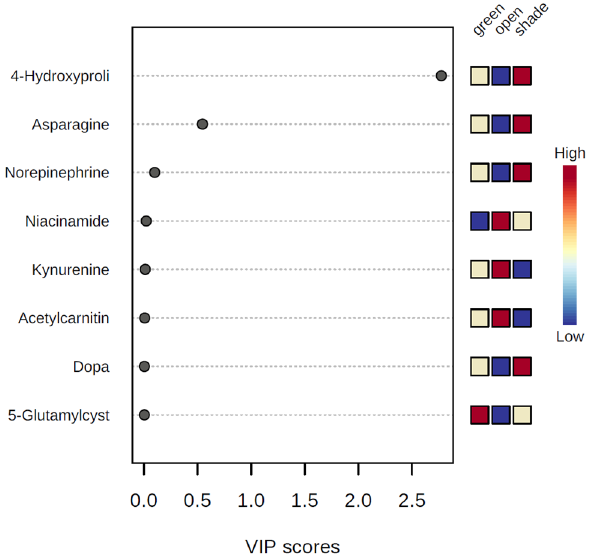
Figure 12. VIP scores of year two [2018/19] primary metabolites of African horned cucumber identified by PLS-DA. The coloured boxes on the right indicate the relative concentrations of the corresponding metabolite in each growing environment (greenhouse, shade net and open